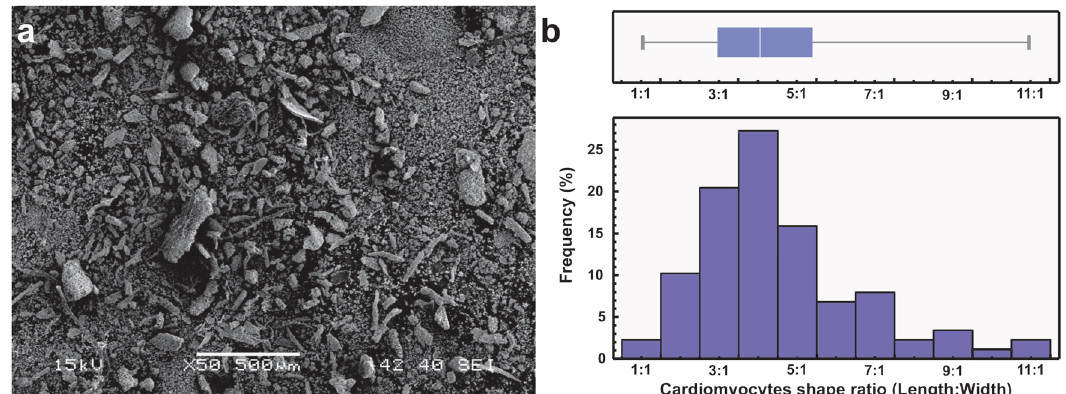
Fig. 6 ARVC cultured with PPPyN after 30 days of culture. a SEM image of fragmented cellular aggregates, b ARVC shape ratio ( R L:W ) histogram and